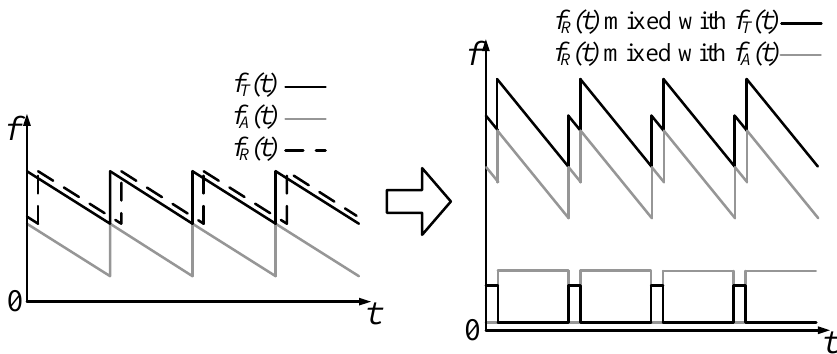
Figure 2. Signal spectrogram of a dual demodulation